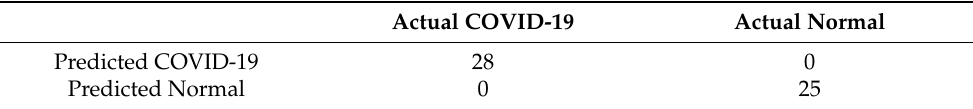
Table 3. Confusion matrix for performance of the Inception-v3 model on chest X-rays.